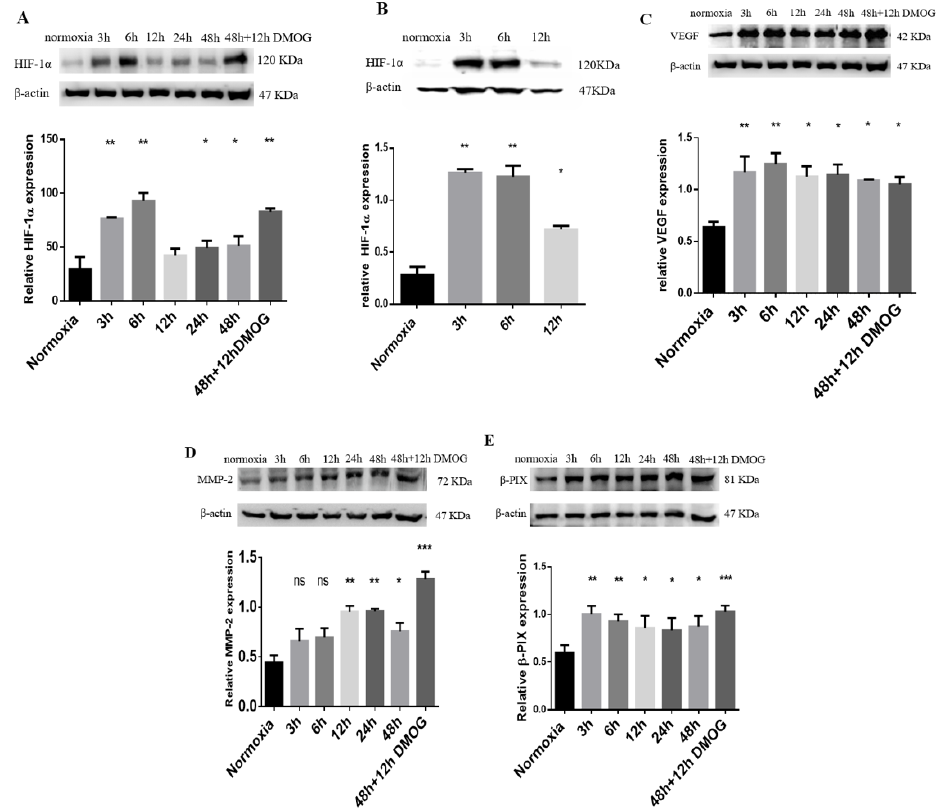
Figure 2. Hypoxia condition increases expression of essential proteins for hypoxia and invadopodium formation. MDA-MB-231 cells incubated in hypoxia chamber alone for 3 to 48 h, and with addition of DMOG for 12 h. ( A ) Hypoxic and normoxic cell lysates probed for hypoxia-inducible factor-1 α (HIF-1 α